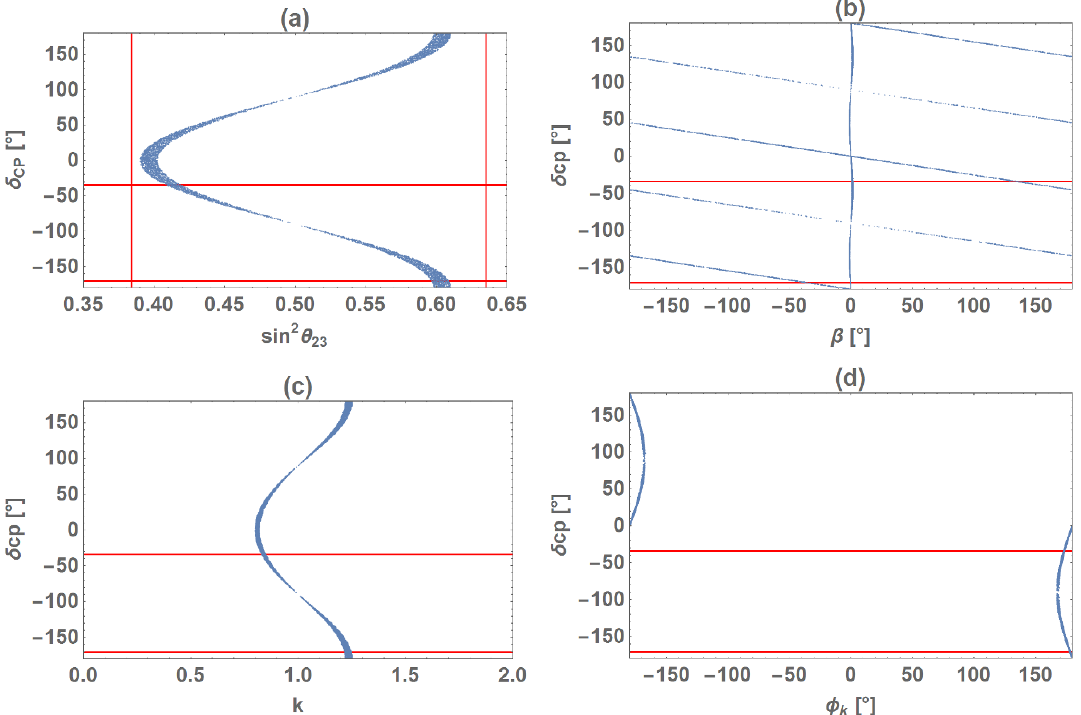
Figure 7 . Predictions for TM 2 in NH, where the red lines for sin 2 (cid:18) 23 and (cid:14) CP denote the experi- mental bounds of 3 (cid:27) (global analyses) and 2 (cid:27) (T2K) ranges, respectively: (a) (cid:14) CP versus sin 2 (cid:18) 23 , (b) (cid:14) CP versus Majorana phase (cid:12) , (c) (cid:14) CP versus k , and (d) (cid:14) CP versus (cid:30) k